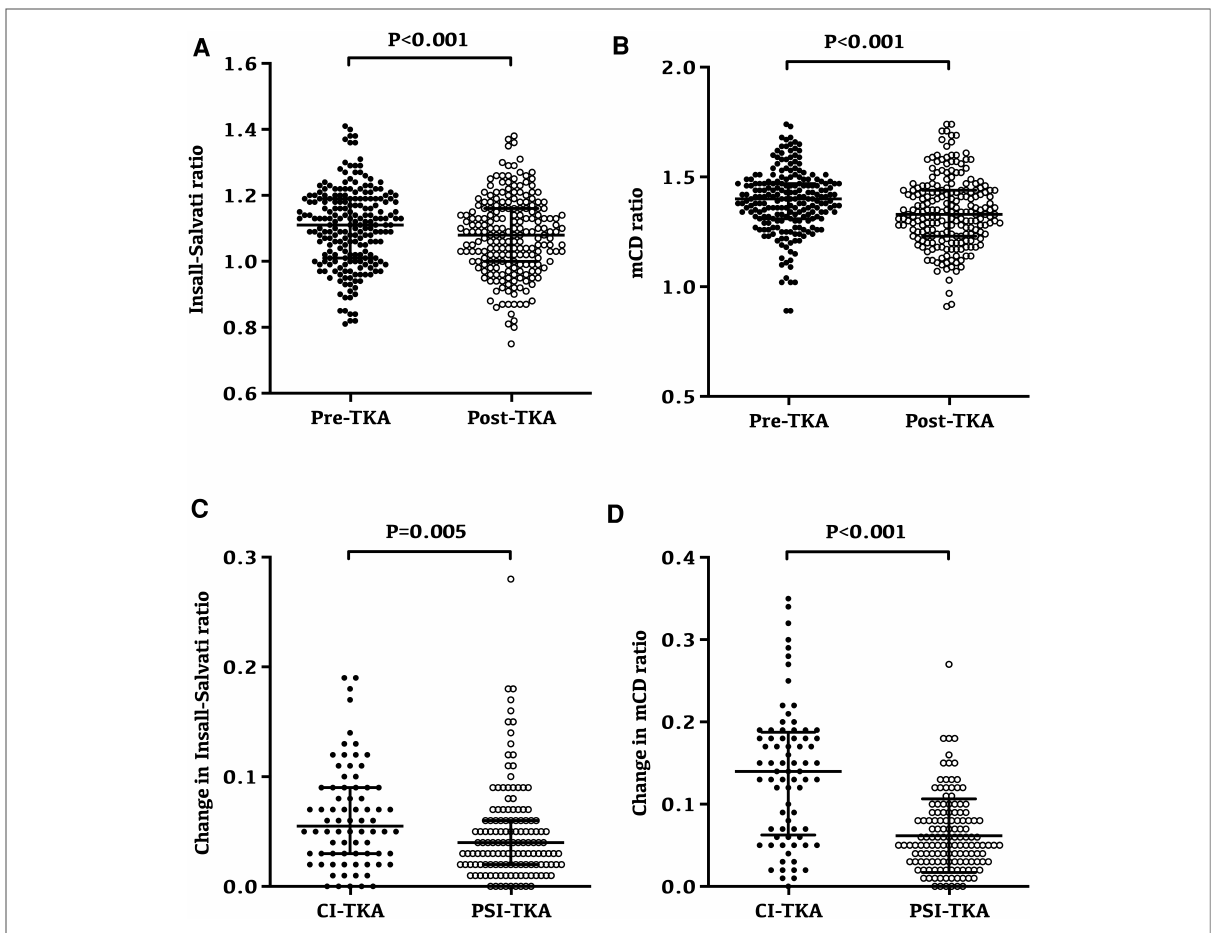
FIGURE 3 Changes and variability of patellar height following TKA. ( A ) Preoperative and postoperative Insall – Salvati ratio for all patients; the Insall – Salvati ratio was 1.11±0.12 preoperatively and reduced to 1.08±0.12 after TKA ( p <0.001). ( B ) Preoperative and postoperative modi fi ed Caton – Deschamps ratio for all patients; the modi fi ed Caton – Deschamps ratio was 1.39±0.14 preoperatively and reduced to 1.34±0.16 after TKA ( p <0.001). ( C ) Insall – Salvati ratio after TKA had a minor change in the PSI-TKA group ( p =0.005). ( D ) Modi fi ed Caton – Deschamps ratio after TKA also had a minor change in the PSI-TKA group ( p